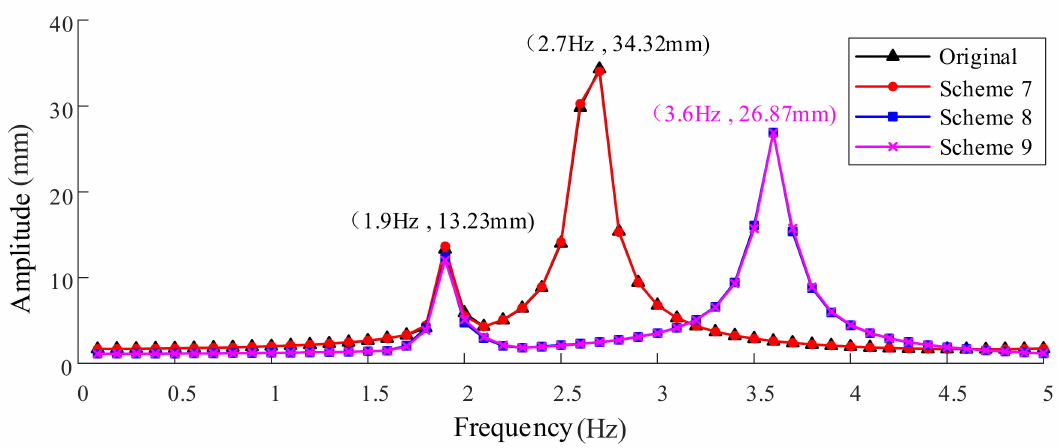
Figure 11. The vibration amplitude of the original large headframe and the improved headframe under the schemes 7, 8, and